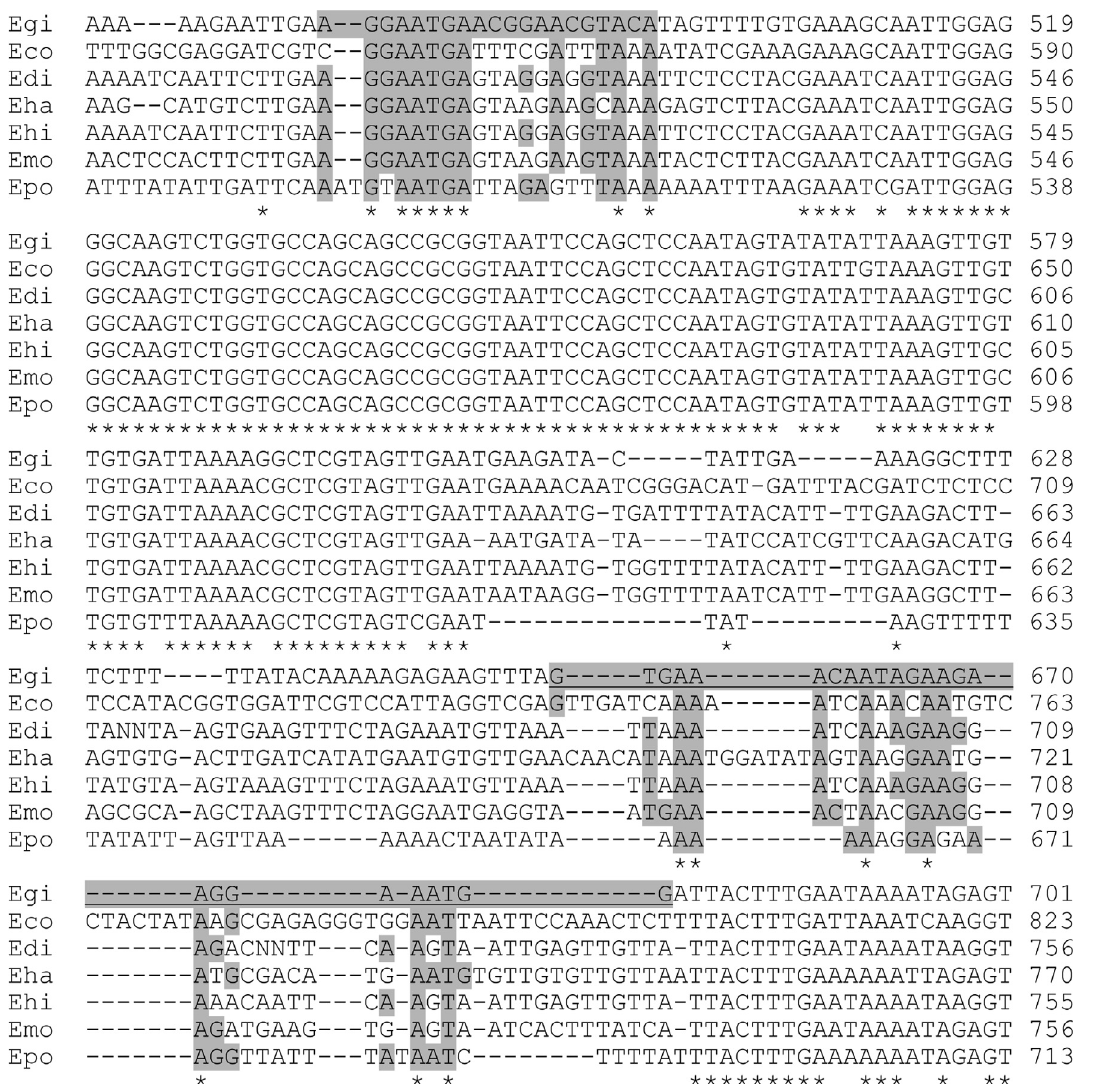
Figure 1. Small subunit ribosomal RNA sequence comparison for Entamoeba species found in humans. E. gingivalis (Egi), E. coli (Eco), E. dispar (Edi), E. hartmanni (Eha), E. histolytica (Ehi), E. moshkovskii (Emo) and E. polecki (Epo) sequences are displayed. The forward primer used in this study is shaded, the reverse complement sequence to reverse primer is shaded and